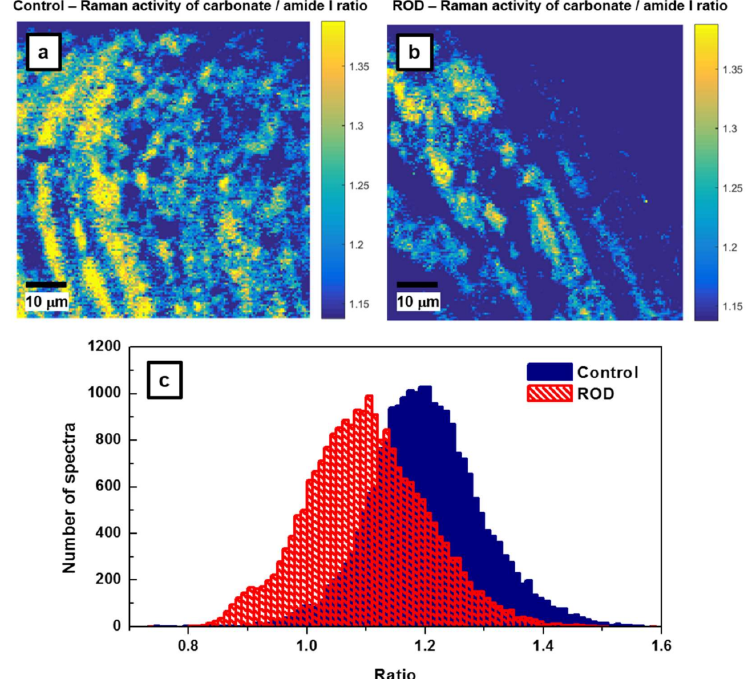
Figure 5. ( a , b ) Raman mapping images for the control and ROD bone samples of carbonate/amide I ratios, which correspond to activities of the bands centered around 1074 cm − 1 and 1660 cm − 1 , respectively. This ratio is associated with bone remodeling and turnover rate. ( c ) Statistical analysis associated with Raman mapping images in Figure